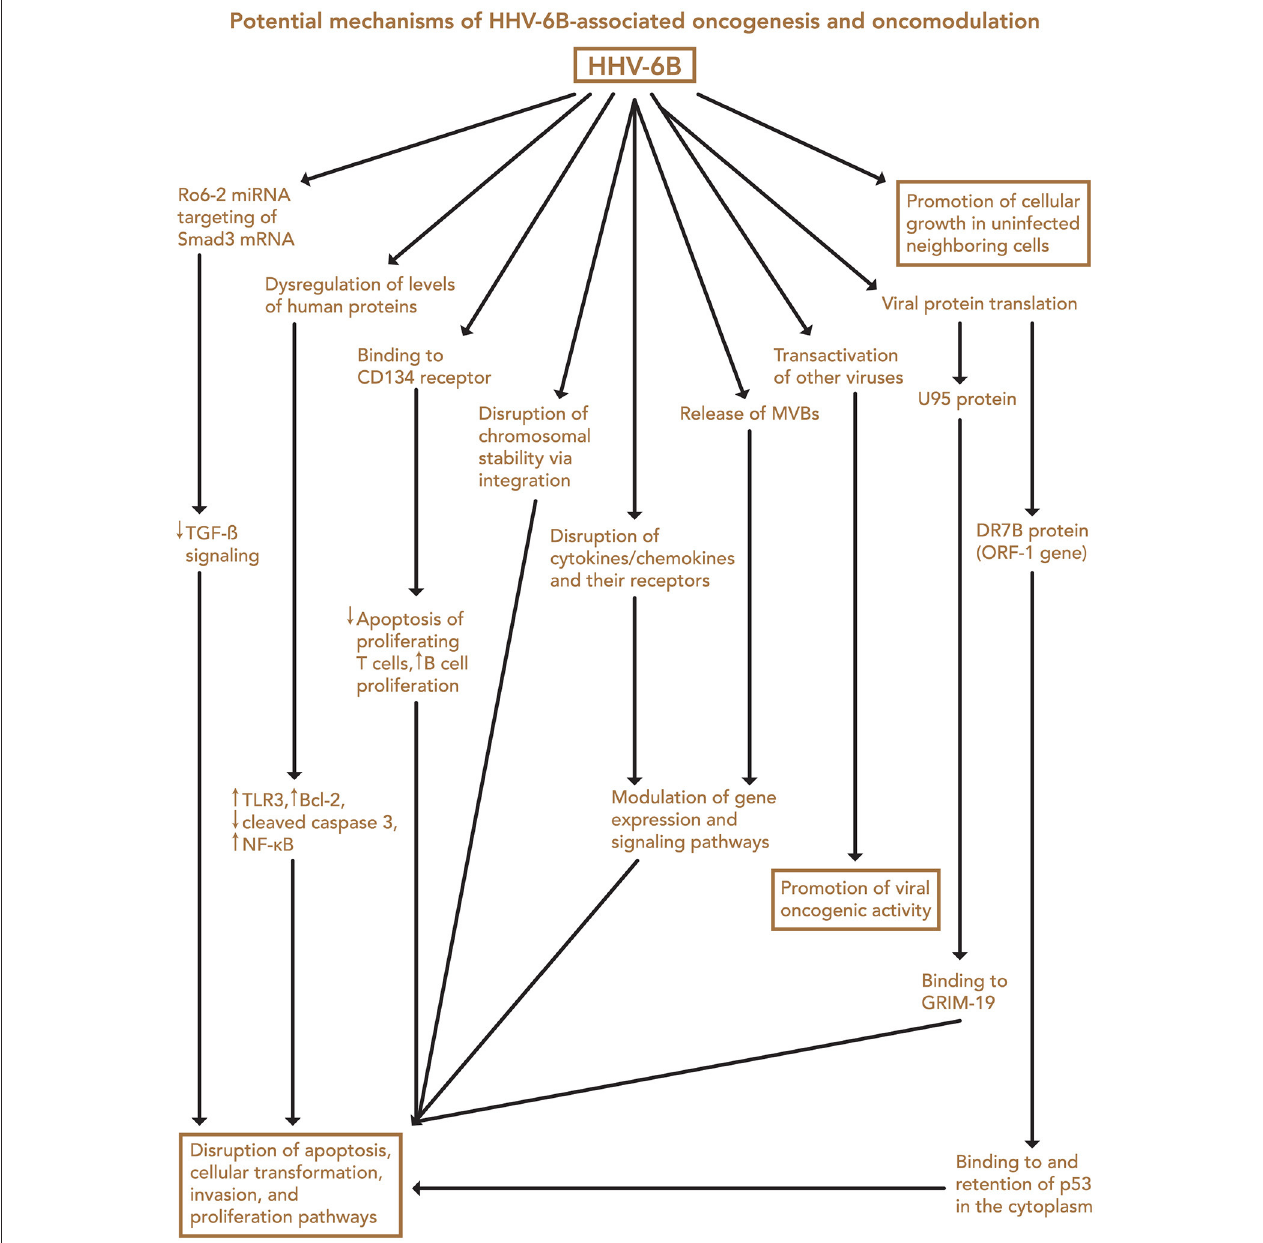
FIGURE 4 | Potential mechanisms of HHV-6B-associated oncogenesis and oncomodulation. Several HHV-6B-mediated changes may contribute to disruption of apoptosis, cellular transformation, invasion, and proliferation pathways, and transactivation of other viruses may contribute to their oncogenic activity. In addition, HHV-6B-infected cells may promote cellular growth in neighboring uninfected cells through a presently unknown mechanism. MVB, microvesicular